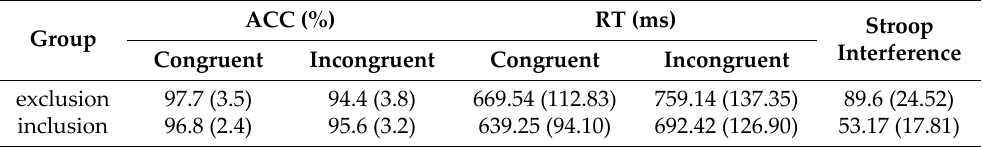
Table 2. Mean (and standard deviations) of the RTs (ms) and ACCs (%) for the cool Stroop task. Group